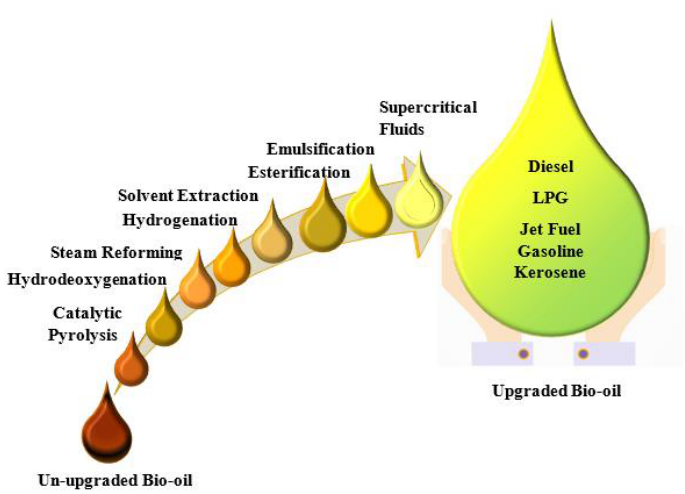
Figure 17. Di ff erent techniques for bio-oil Figure 17. Different techniques for bio-oil upgradation.